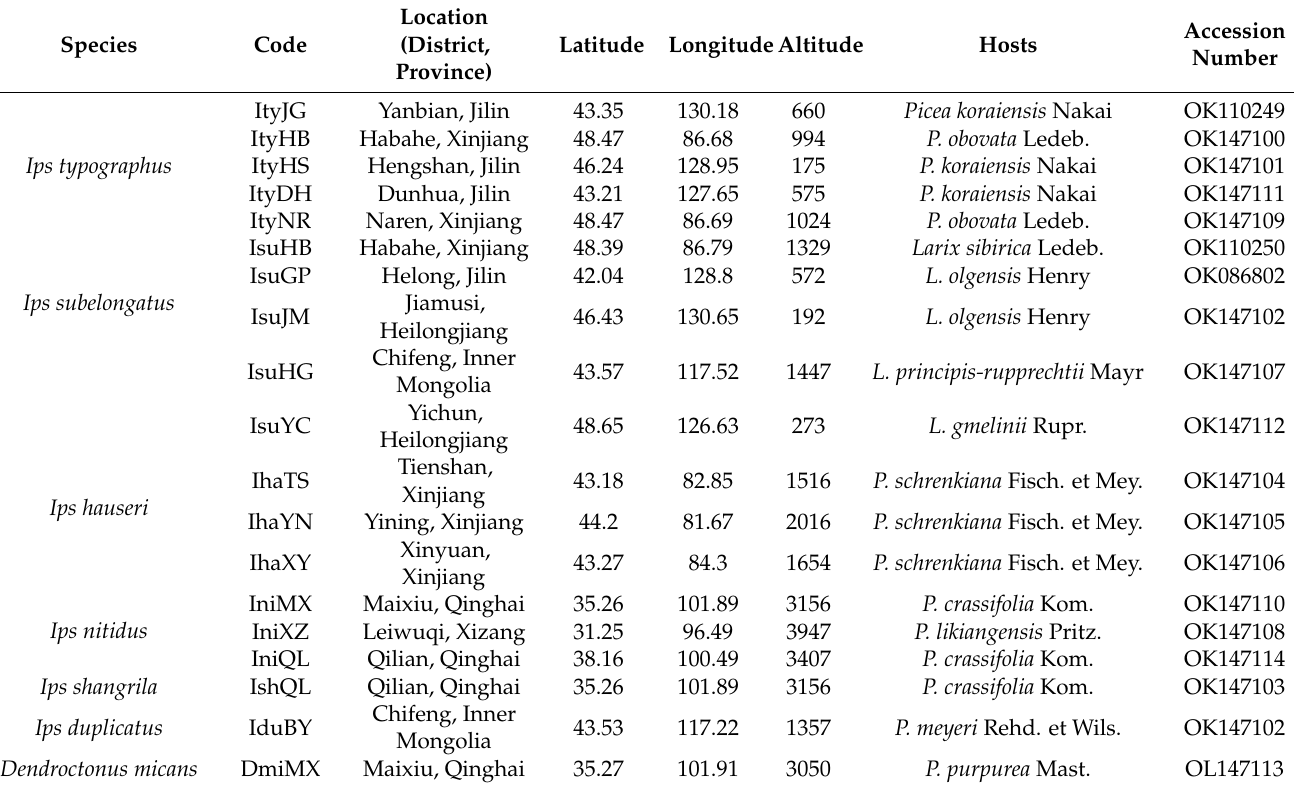
Table 1. The information list of specimens collected in